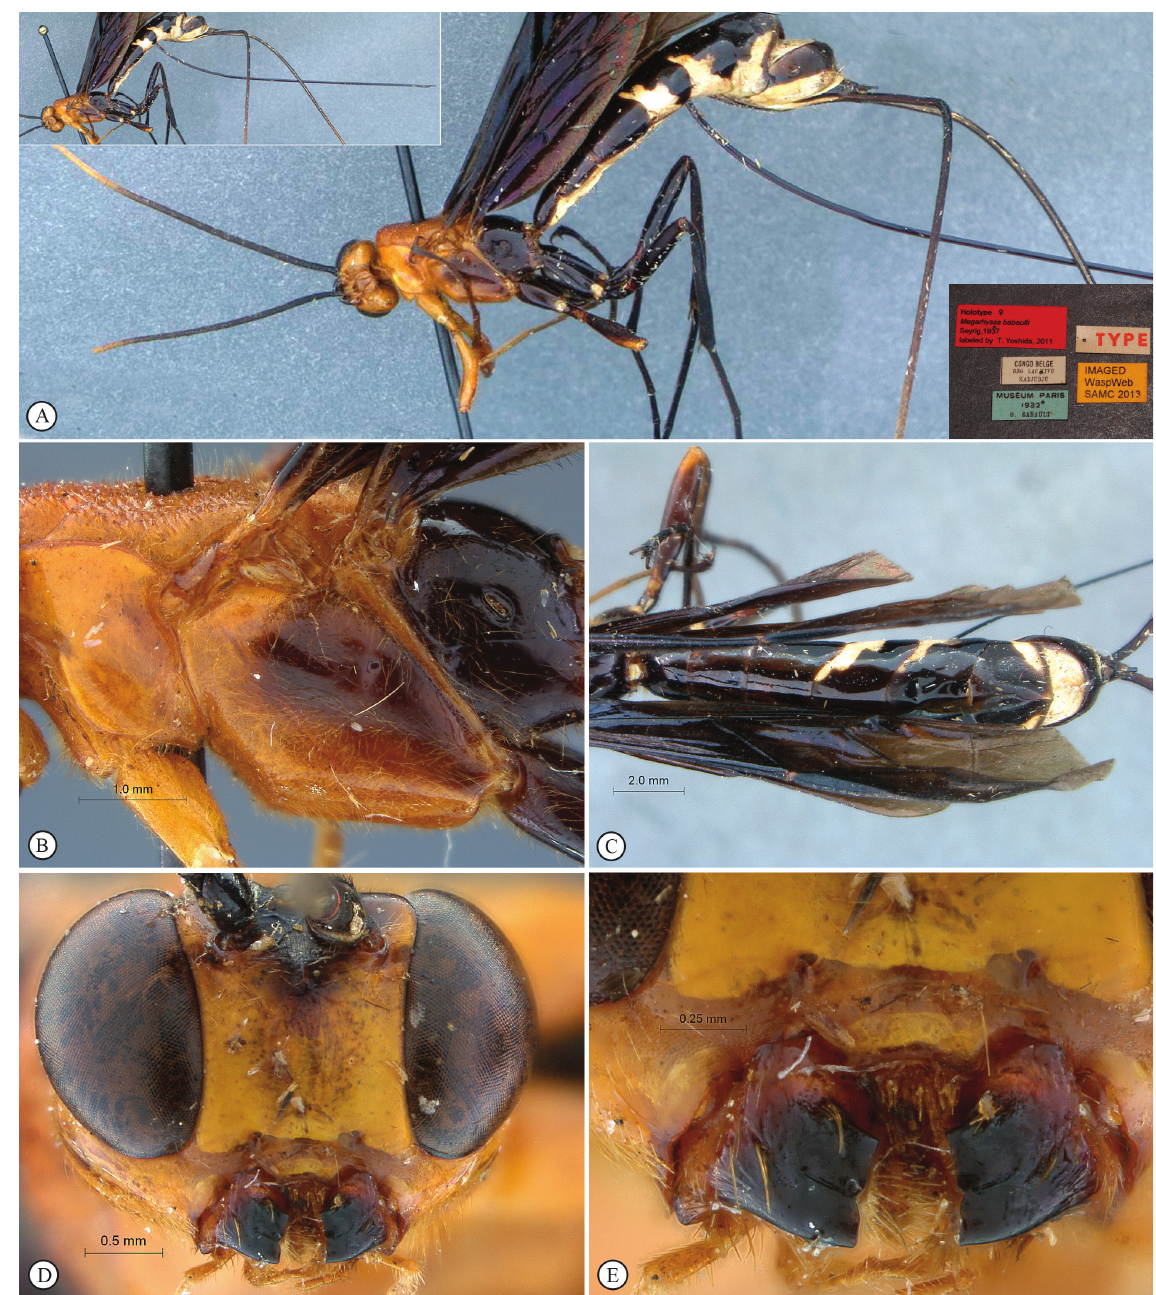
Fig. 12. Megarhyssa babaulti Seyrig, 1937, holotype, ♀. A . Habitus, lateral view (inset: data labels). B . Mesosoma, lateral view. C . Metasoma, dorsal view. D . Head, anterior view. E . Mandibles, anterior